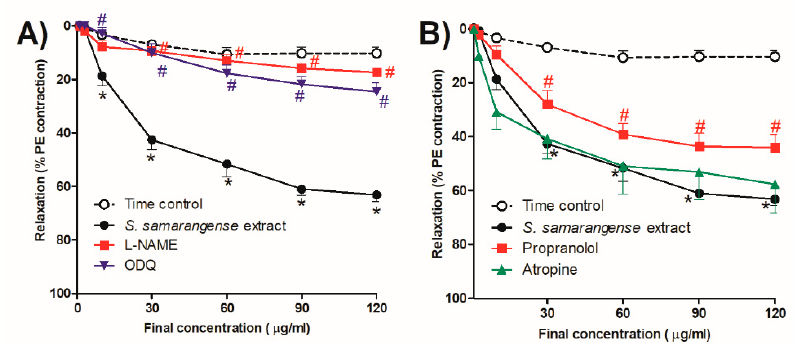
Figure 3. Effects of the cumulative addition of S. samarangense extract doses (1–120 g/mL) on isolated aortae from control rats that had been pre-constricted by phenylephrine (PE, 10 M). The effect of preincubation (30 min) with ( A ) N ω -nitro-L-arginine methyl ester hydrochloride (L-NAME, 100 µ M)as a NO synthase inhibitor, and 1H-(1,2,4)-oxadiazolo(4,3-a)quinoxalin-1-one (ODQ, 1 mM) as a guanylate cyclase inhibitor, ( B ) Propranolol (1 µ M) as a β -adrenoreceptor antagonist, and atropine (100 µ M) as a standard muscarinic receptor blocker, on the vasodilation effect of S. samarangense extract on PE preconstricted aorta sections. The results are displayed as the mean ± standard error of six animals. * p < 0.05, compared with the time control values, # p < 0.05, compared with S. samarangense extract effect on intact endothelium values.